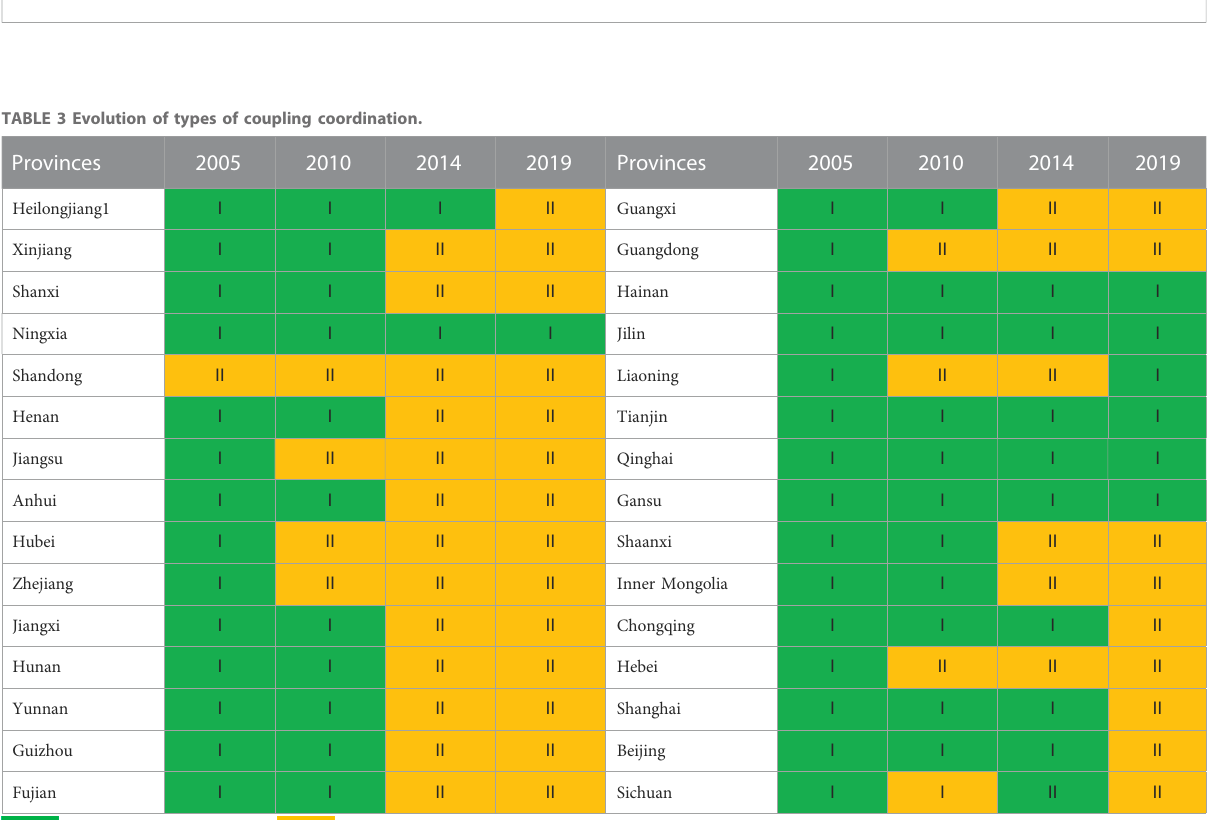
FIGURE 1 Evolution values of coupling coordination.